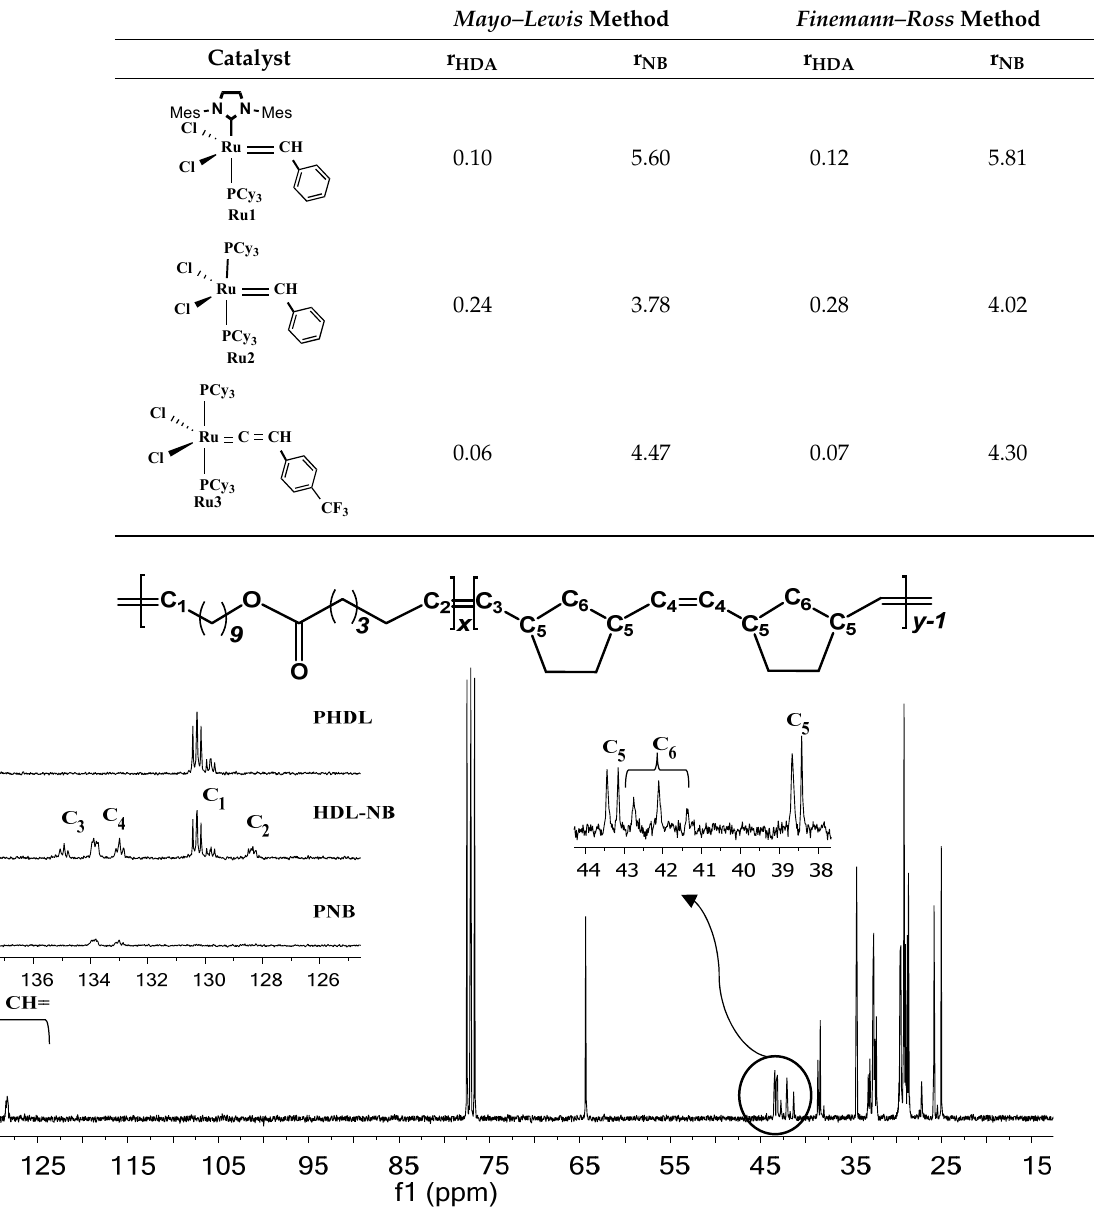
Table 3. Monomer reactivity constants calculated by using Mayo–Lewis and Finemann–Ross methods.